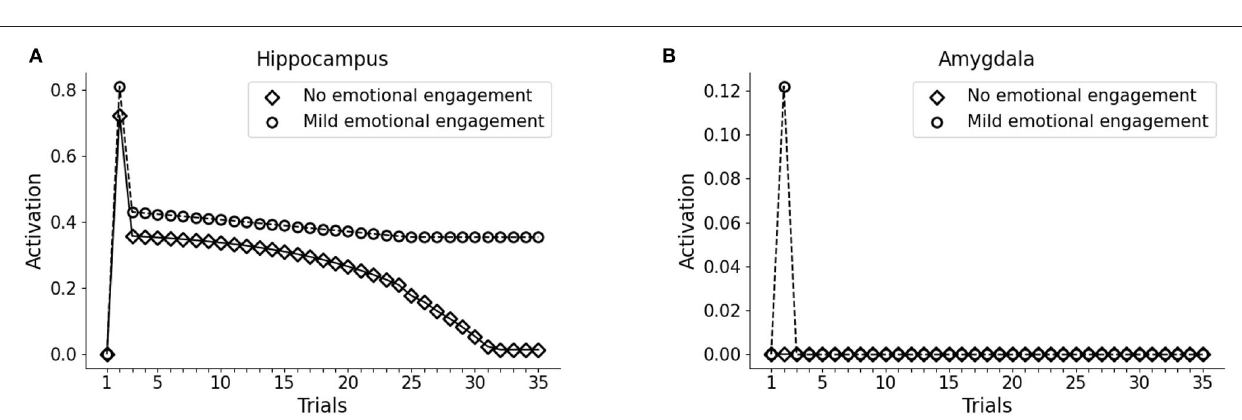
FIGURE 4 | Effect of the high excitability of vmPFC on the triggering of post-traumatic stress disorder (PTSD). Hippocampus (A) and amygdala (B) activity before (trial 1: V1 input), during (trial 2: V1-A1-S1-Trauma input) and after (trial 3–35: V1 input) trauma, in a model where the vmPFC firing threshold is halved (white dots) compared to the model shown in Figure 2 acquiring the PTSD (black dots).